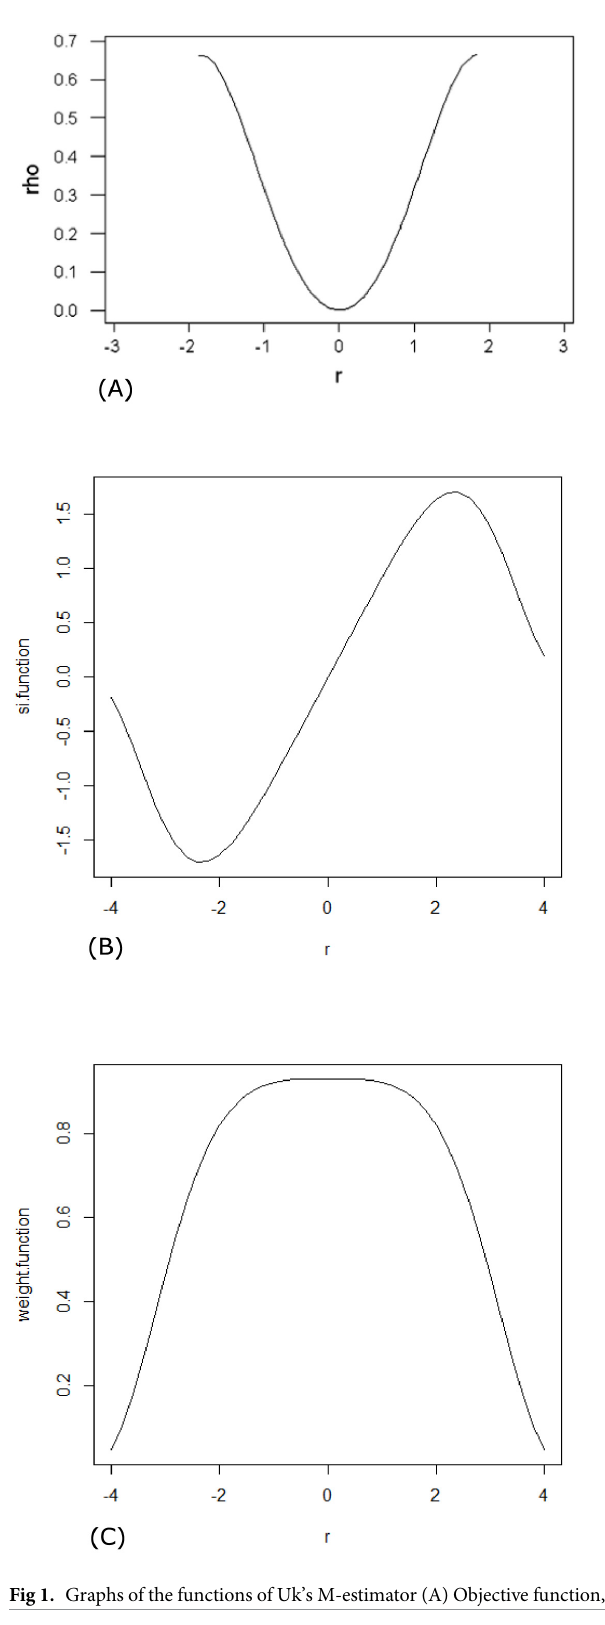
Fig 1. Graphs of the functions of Uk’s M-estimator (A) Objective function, (B) C -function and (C) weight function. https://doi.org/10.1371/journal.pone.0278868.g001 PLOS ONE | https://doi.org/10.1371/journal.pone.0278868 December12,